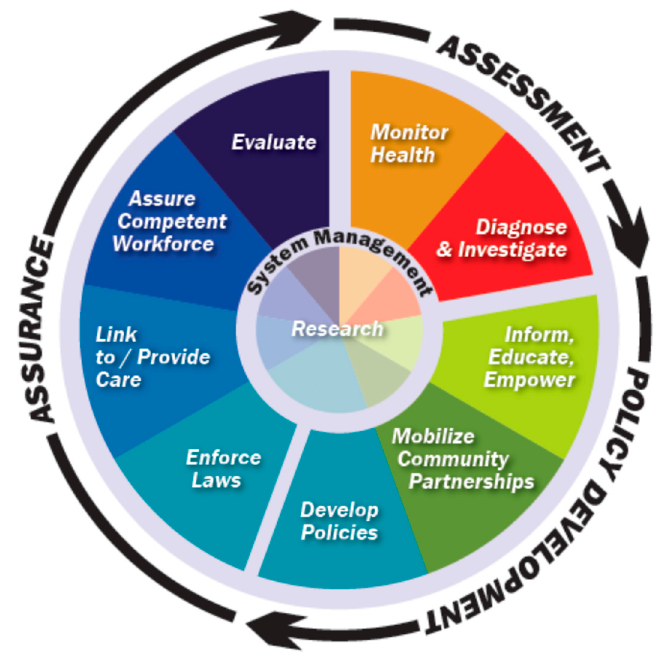
Figure 1. The core functions and essential services (CFES) model [24].